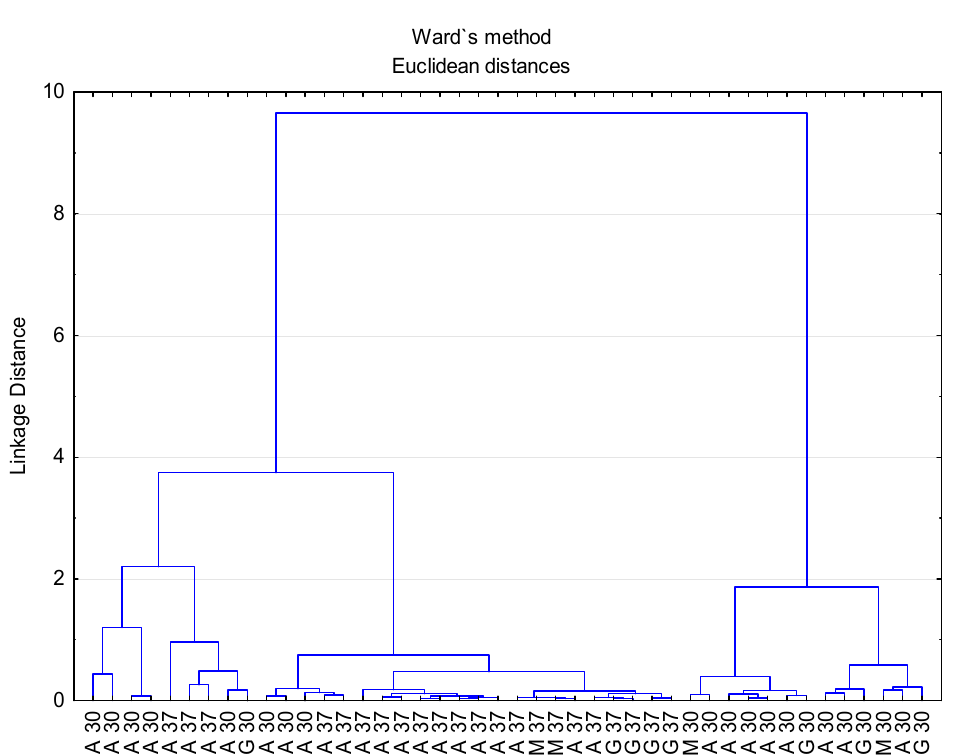
Figure 3. Cluster analysis taking into consideration the composition of volatile compounds of vinegar samples. A 30/A 37: Acetobacter at 30 ◦ C and 37 ◦ C, G 30/G 37: Gluconobacter at 30 ◦ C and 37 ◦ C, M 30/M 37: Mixture of bacteria at 30 ◦ C and 37 ◦ C. Table 4. Mean concentrations (ppm) and standard deviations of phenolic compounds identified by UPLC-DAD in different prickly pear matrices (juice, wine, vinegar). Results of analysis of variance taking into account the matrix.